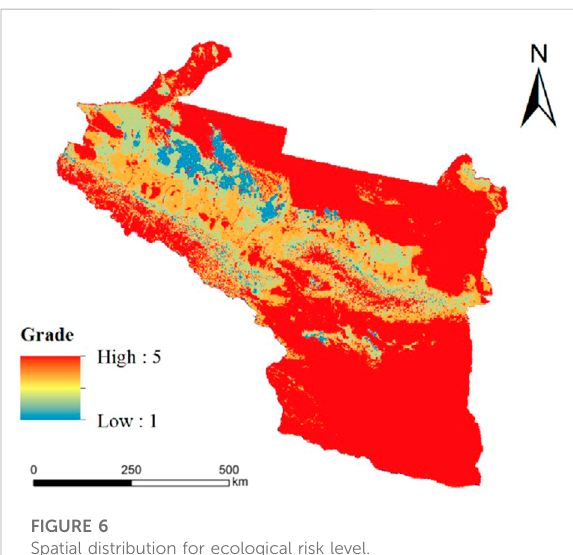
FIGURE 6 Spatial distribution for ecological risk